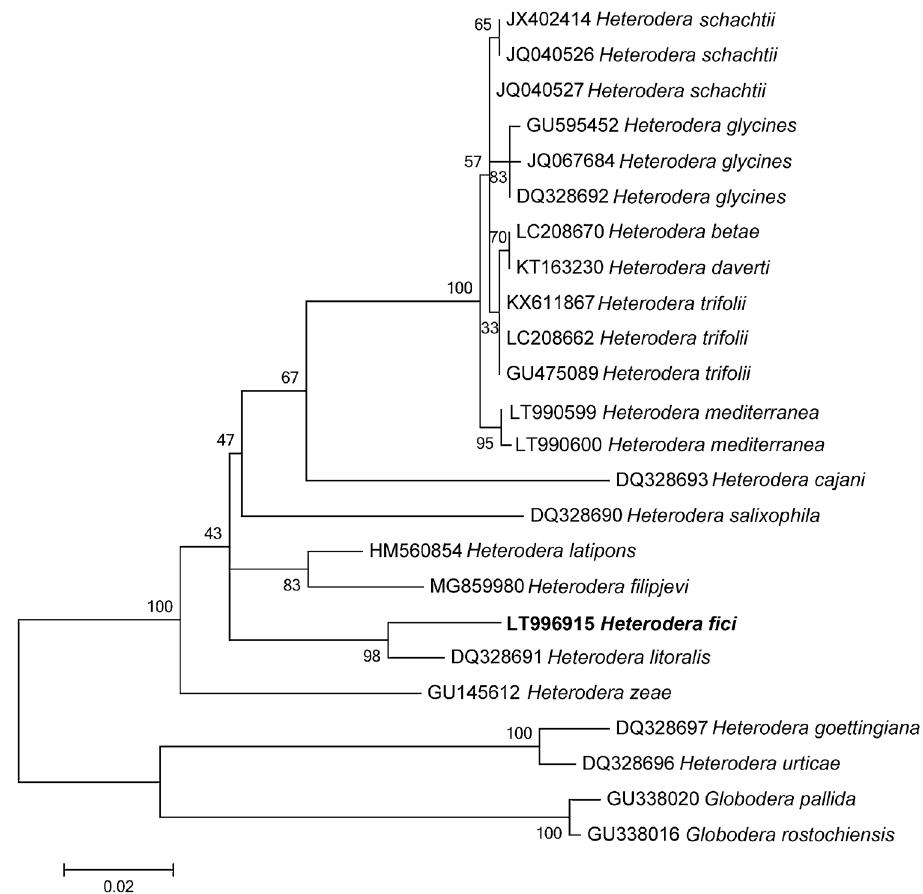
Figure 7. Phylogenetic trees of the D2–D3 expansion domains of the 28S rRNA gene of Heterodera fici and the closest species. Sequences were analysed using the Maximum Likelihood method. Numbers at nodes indicate bootstrap